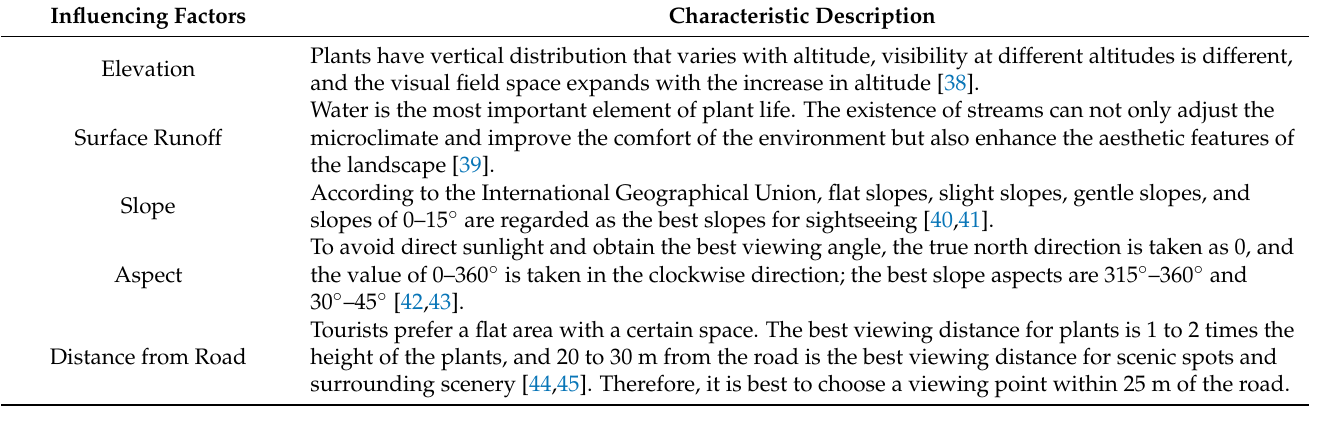
Table 1. Spatial characters of the ideal viewpoint in the study area.